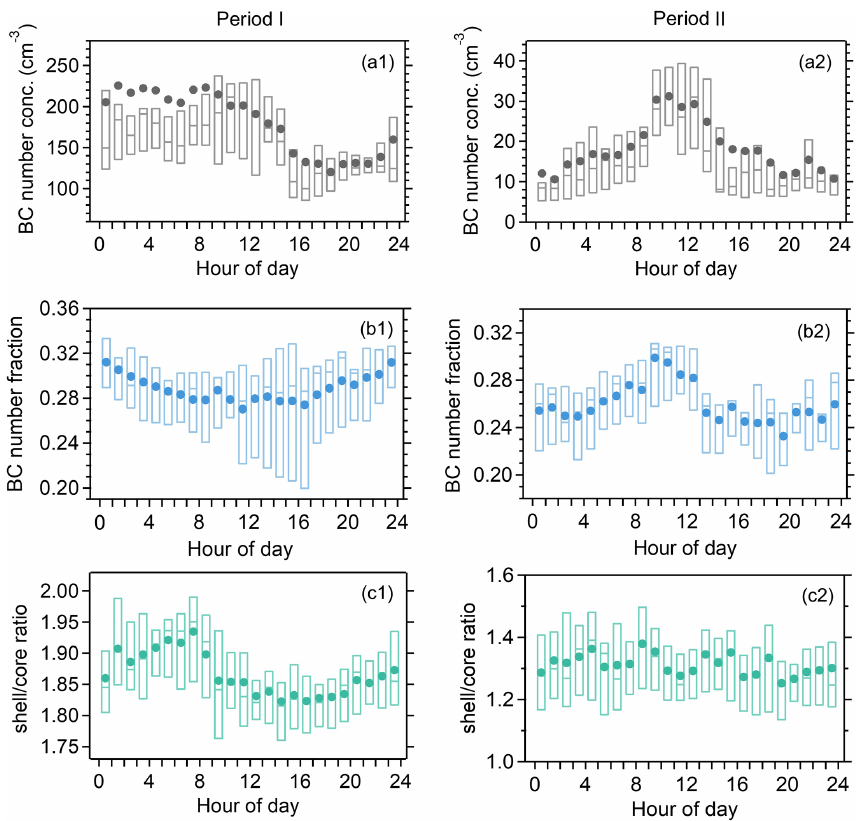
Figure 3. Diurnal variation in BC number concentration (a) , BC number fraction (b) , and shell / core ratio (c) during Period I and Period II. The solid dots are the mean values. The rectangles cover the data from the 25% to 75% quantile. The short lines in the middle of the rectangles represent the median